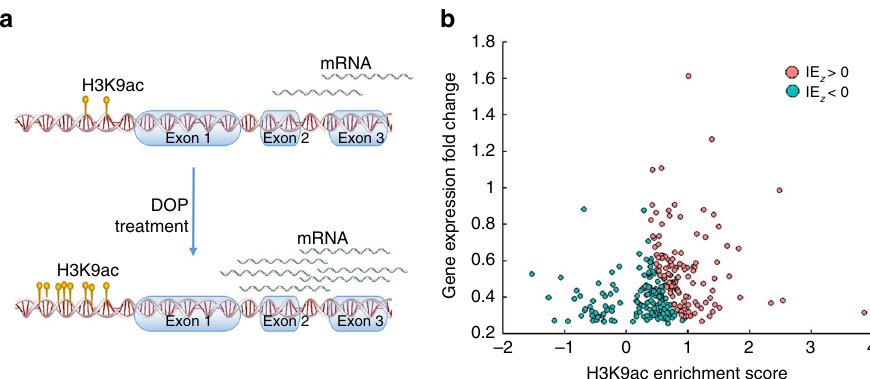
Fig. 10 Identifying genes whose expression levels are associated with an increase in H3K9ac in the promoter. a Schematic representation of a gene whose expression level increases after DOP treatment, and which has an associated increase in H3K9ac level in the promoter. b The scatter plot shows the H3K9ac score for each gene vs. the fold change of expression levels. Each dot represents a gene that is upregulated after treating STHdh Q111 cells with DOP and that has at least one H3K9ac peak within 10 kb of the promoter. The X -axis shows the H3K9ac score for these genes. Higher scores indicate higher levels of H3K9ac after the treatment with DOP. The Y -axis shows the fold-change in gene expression after the DOP treatment. Genes whose expression levels are associated with an increase in H3K9ac are colored red ( z -score of interaction effect (IE Z ) mutant huntingtin expression construct for human huntingtin exon-1 containing a 73 CAG repeat (Httex1-Q73). DOP was added to cultures at the time of slice preparation and transfection at the indicated concentrations. After 4 days, YFP co-transfected MSNs were identi fi ed based on their location in the striatal regions 34, 35 . MSNs exhibiting typically sized cell soma, continuous and even expression of YFP in the cell body and all processes, and at least two clear primary dendrites that were at least two cell bodies long were scored as healthy.